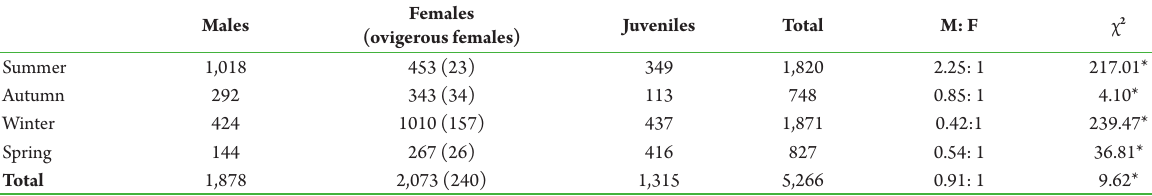
Table 1. Number of males, females, ovigerous females, juveniles and total specimens of Hyalella bonariensis , sex ratio (males: females) and results of the χ 2 test by sampling seasonal in Silveira Martins, state of Rio Grande do Sul, Brazil.